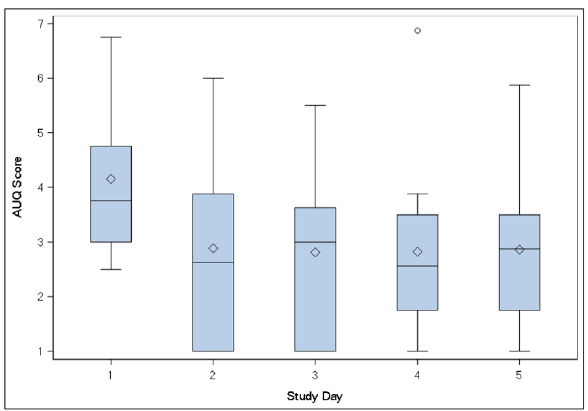
Figure 4. AUQ total score across study day; AUQ score is the average response across 8 questions (range 1:7). For comparability, the 09:30 AM collection was used for days 1 and 5. The box represents the Interquartile Range (IQR, 25th percentile to 75th percentile). Within the box, the horizontal line is the median and the symbol (triangle for day 1 and circle) is the mean. Whiskers represent the min/max, with the exception of outliers which fall outside the IQR by a distance greater than 1.5 times the IQR